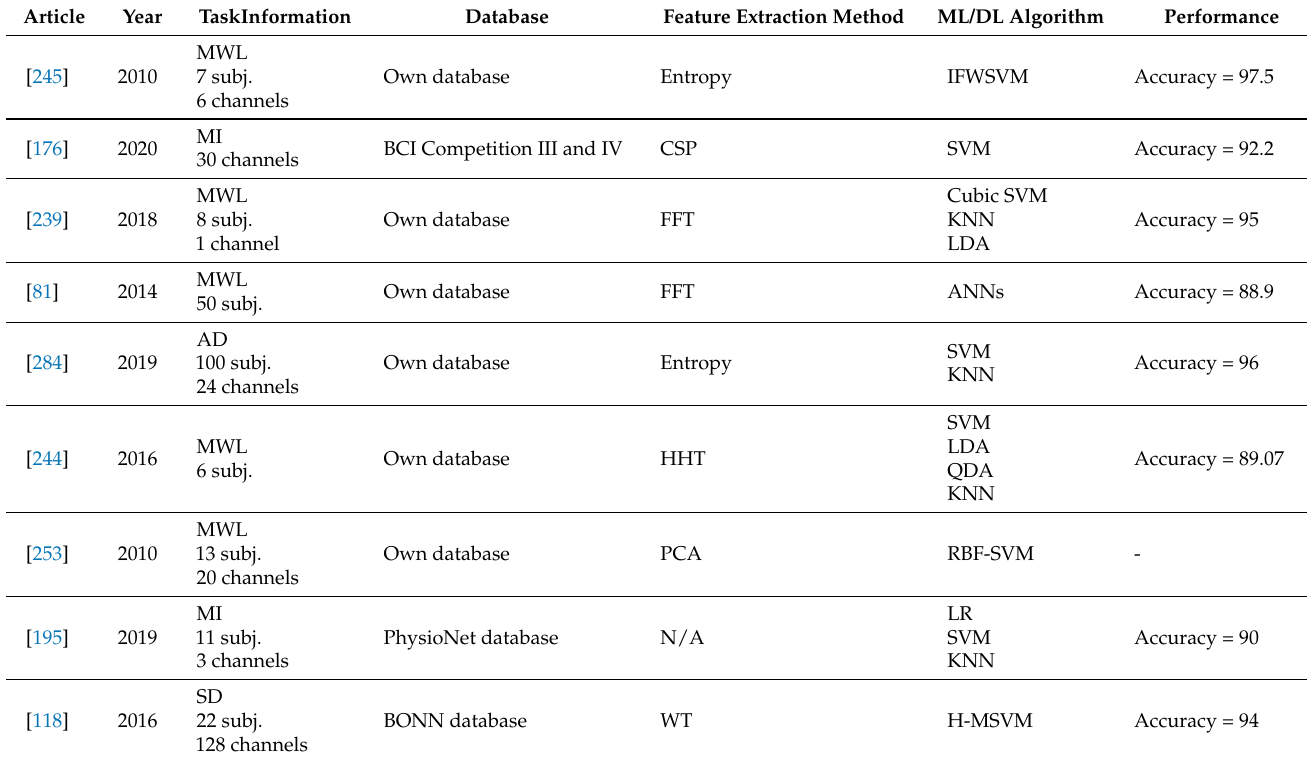
Table A1. Summary of the ML/DL Algorithm-related studies included in this systematic